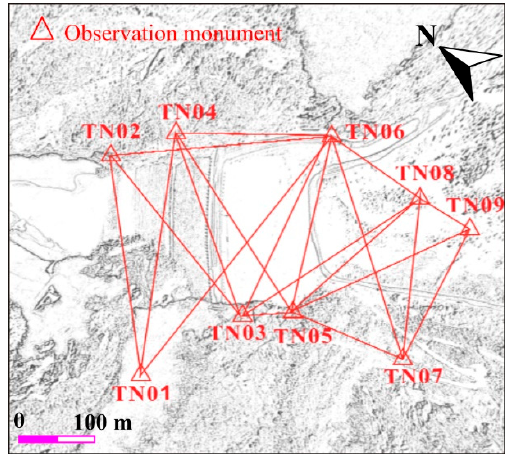
Figure 2. Layout of the geodetic network.